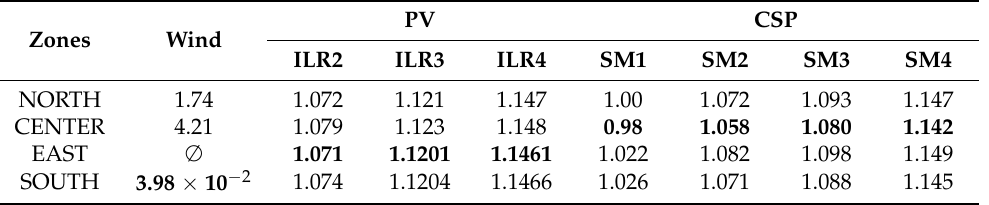
Table 7. Ratios (no units) given by ([51], Equation (14)). SM1: CSP without storage; ILR > 1 or SM > 1: with increasing levels of storage from PV or